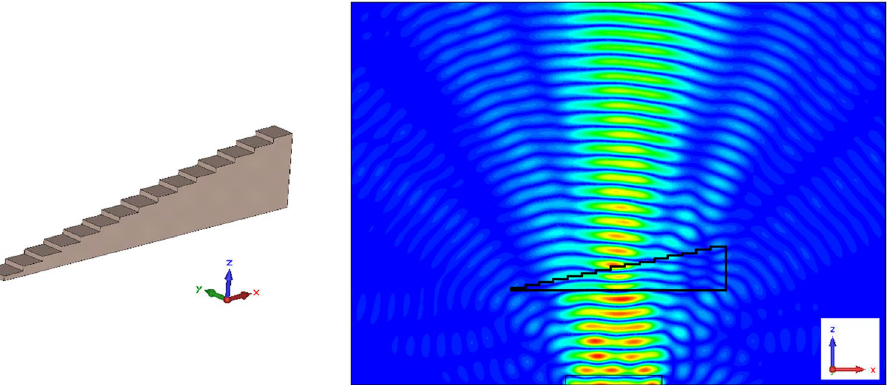
Figure 10. Simulation of the refraction of a plane wave by a Teflon prism. On the left: representation of the simulated Teflon prism, made of 15(15 + 1)/2 blocks of Teflon with dimensions 150 × 150 × 30 μm. On the right: XZ plane section of the absolute value of the electric field generated by a plane wave incident upon the lower interface of the prism. Generated using CST Microwave Studio 30